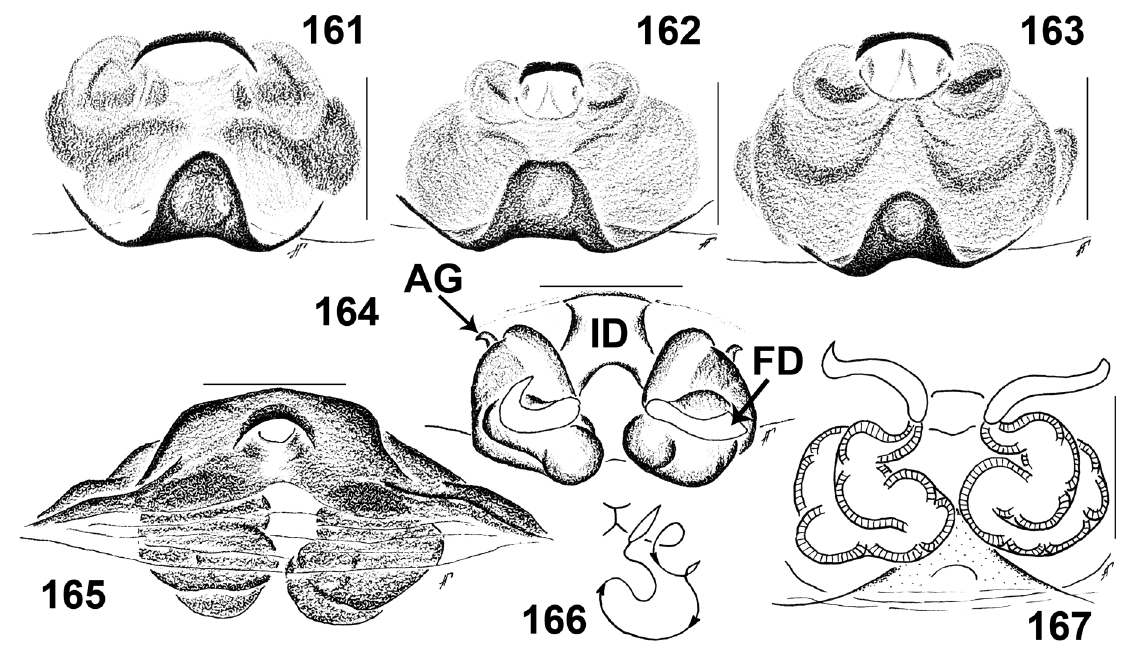
Figs 161–167. Manzuma petroae gen. et sp. nov., paratypes, ♀♀ from Ithala GR (161, 164–165, 167, NCA 2019/712), Midrand (162, NCA 2009/3732) and Mpofu NR (163, NCA 2011/826). 161–163 . Epigyne, ventral view. 164 . Spermathecae, apical view. 165 . Epigyne, basal view. 166 . Diagrammatic course of the insemination ducts. 167 . Spermathecae, dorsal view. Scale bars: 0.1